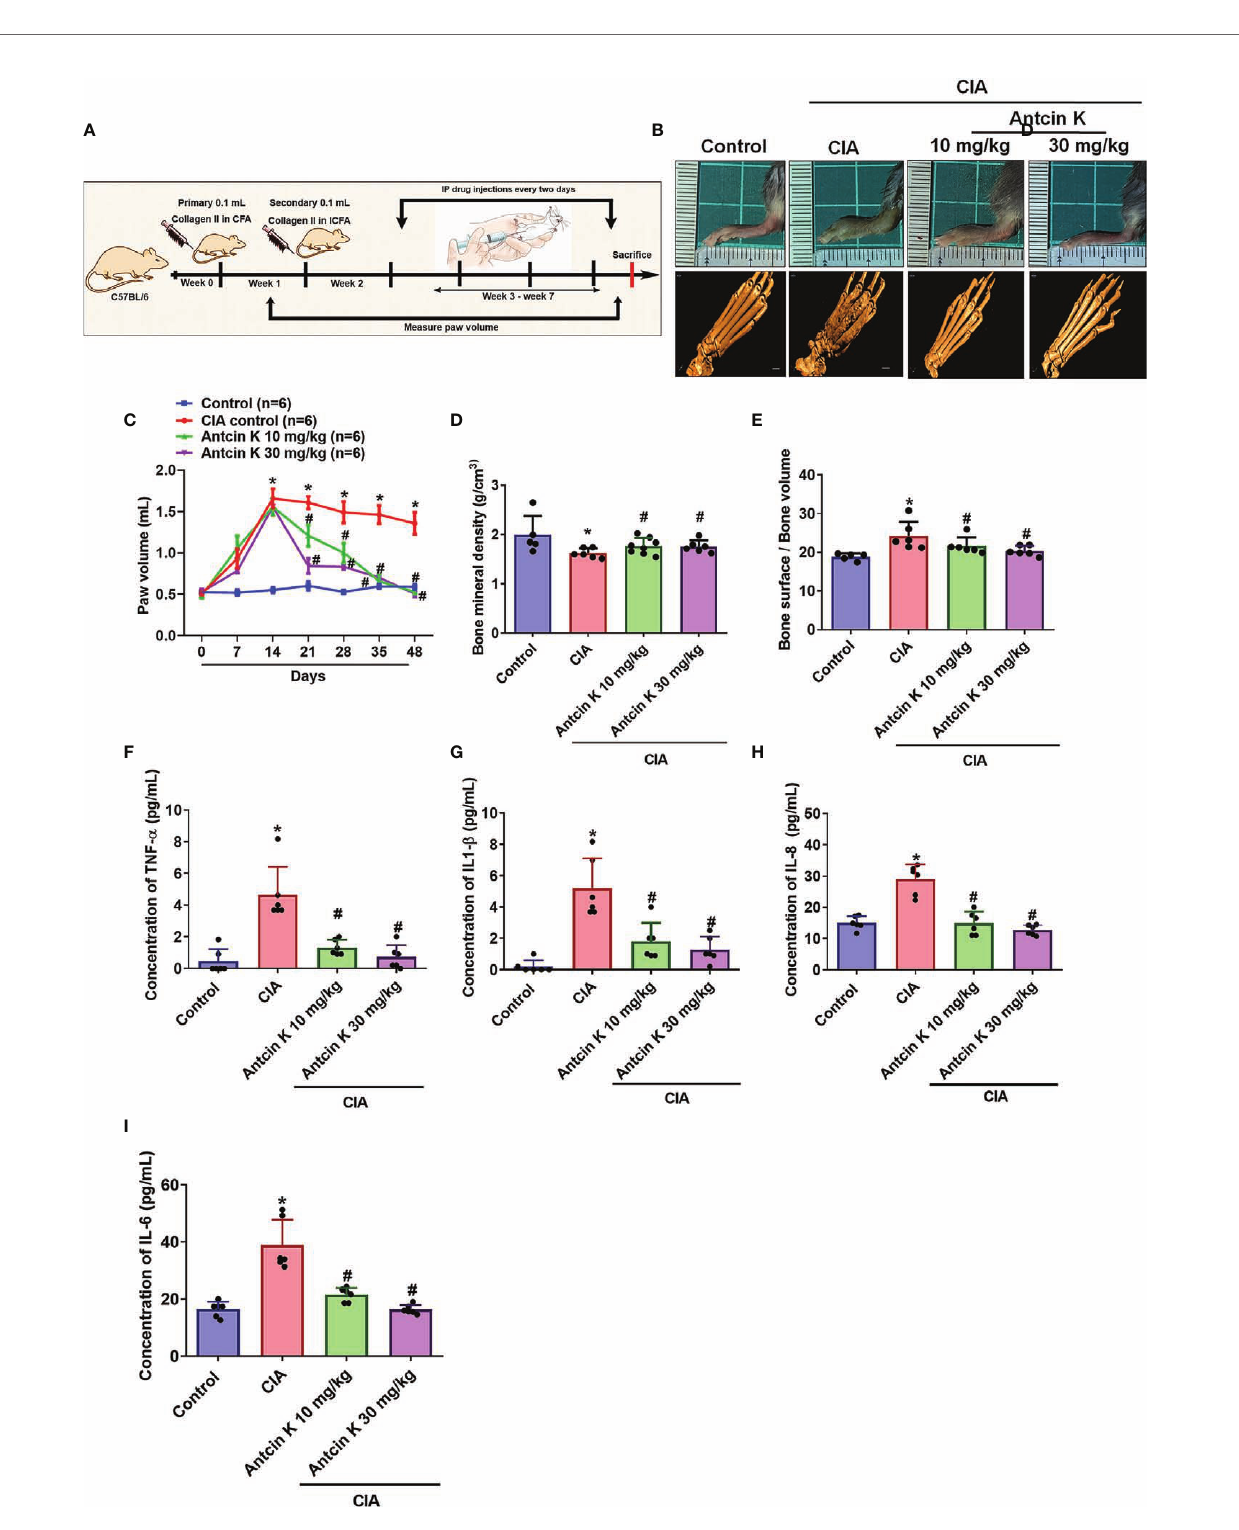
FIGURE 7 | Antcin K ameliorated paw swelling and cartilage degradation in CIA mice. (A) Work fl ow of CIA induction and Antcin K injections. (B, C) Hind paw swelling was photographed and measured with a digital plethysmometer in healthy controls, untreated CIA mice, and in CIA mice administered Antcin K 10 mg/kg or 30 mg/kg for 48 weeks. Representative micro-CT images of the hind paws were recorded on Day 48. (D, E) Quanti fi cations of bone volume, bone surface, and bone density. (F – I) Serum levels of TNF- a , IL-1 b , IL-6 and IL-8 were analyzed by ELISA. Results are expressed as the mean ± SD. *P < 0.05 compared with controls; # P < 0.05 compared with the untreated CIA